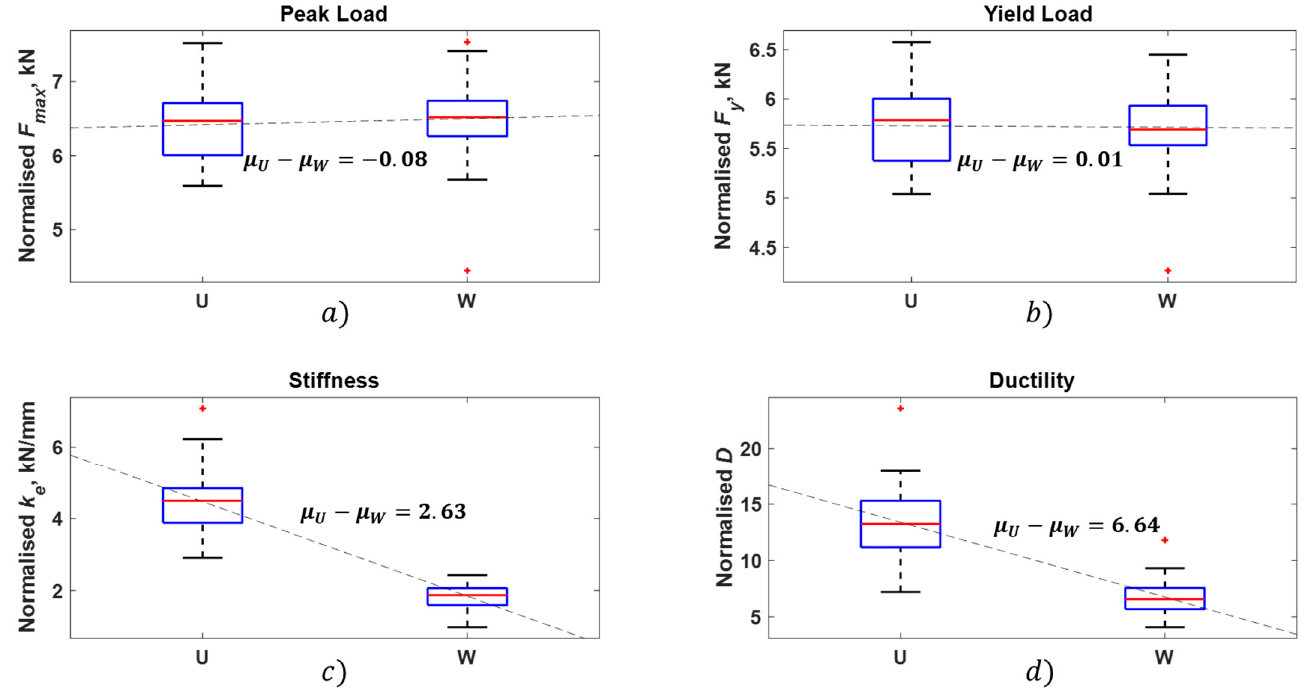
Forests 2023 , 14 , x FOR PEER REVIEW 16 of 26